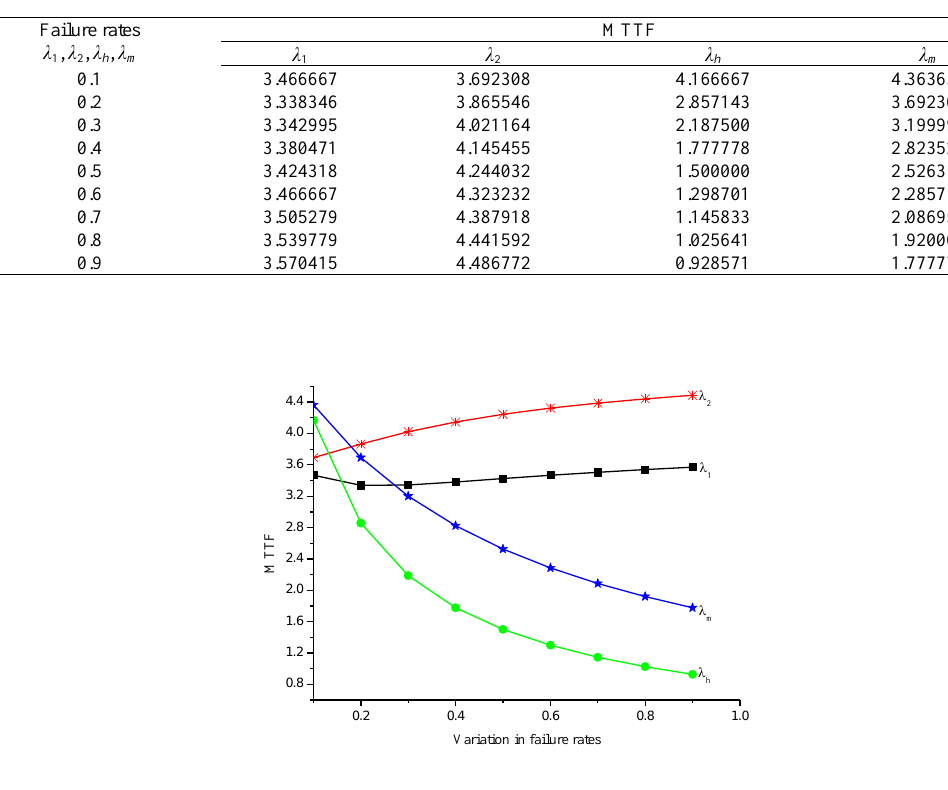
Figure 10. MTTF of the system without